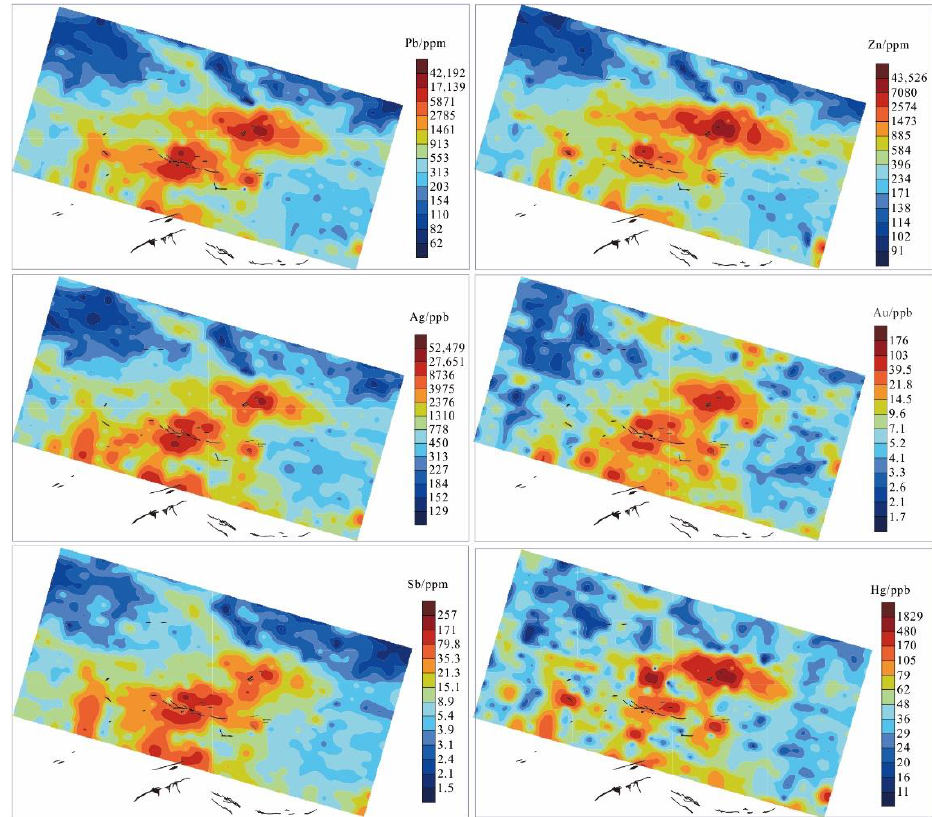
Figure 7. Geochemical map of the fine-grained soil prospecting method in Huaniushan Pb-Zn de- posit.